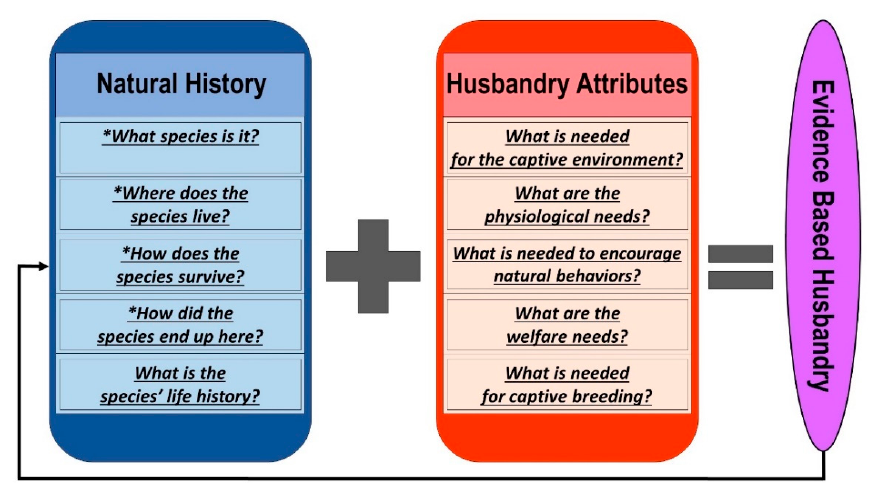
Figure 1. Model of the relationship of Bartholomew’s natural history questions and life history information along with questions specific to husbandry attributes when answered lead to evidence based husbandry, which in turn can lead to potential novel natural history observations (black arrow).